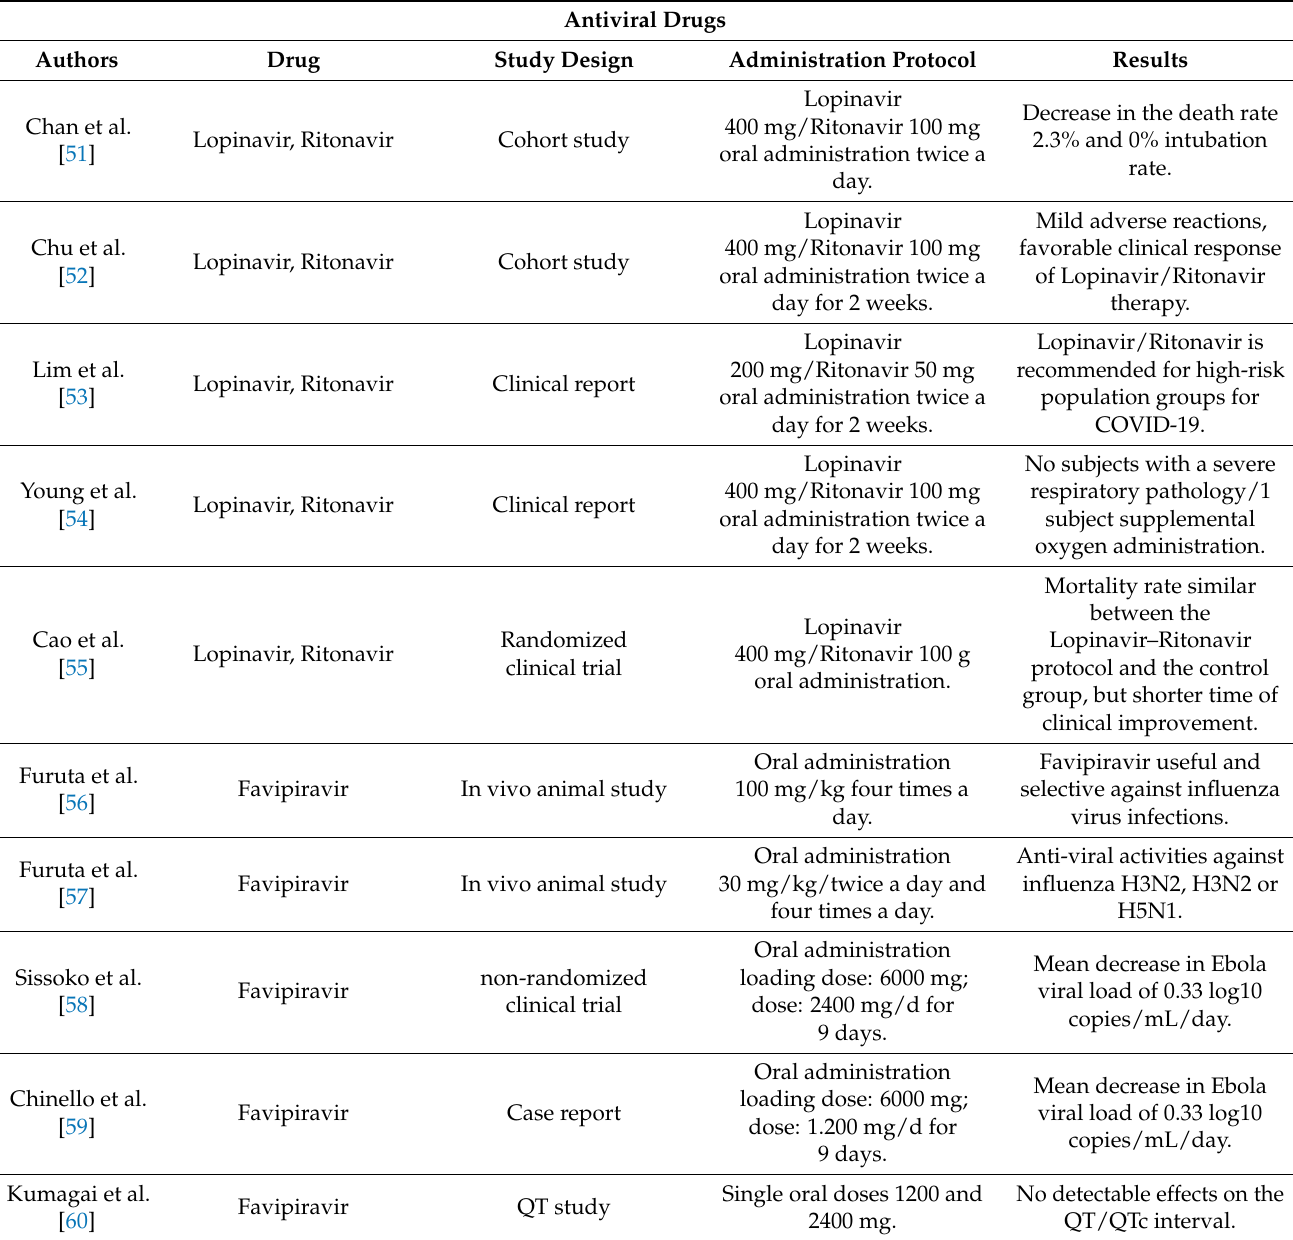
Table 2. Summary of the in vivo studies included about antiviral drug therapies for viral